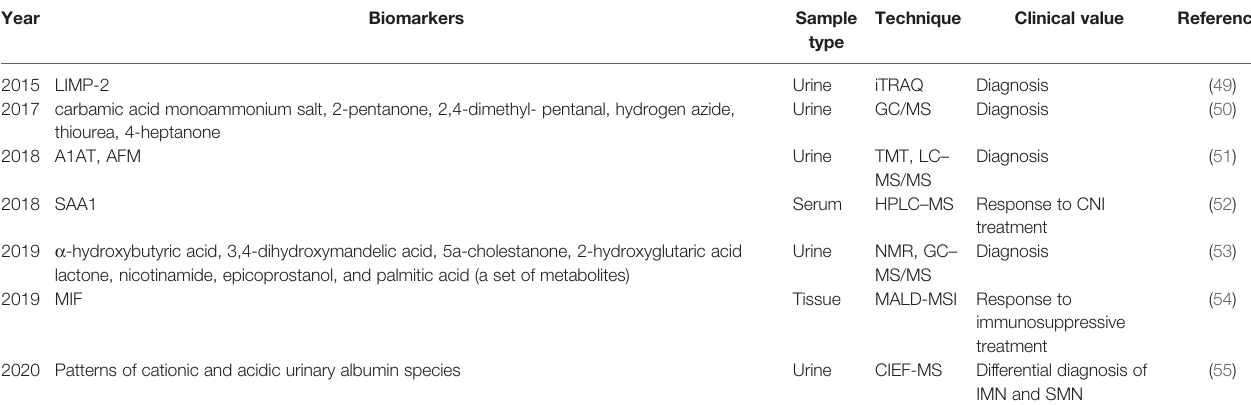
TABLE 2 | Summary of research progress on MN-related non-podocyte target antigen proteins and metabolic